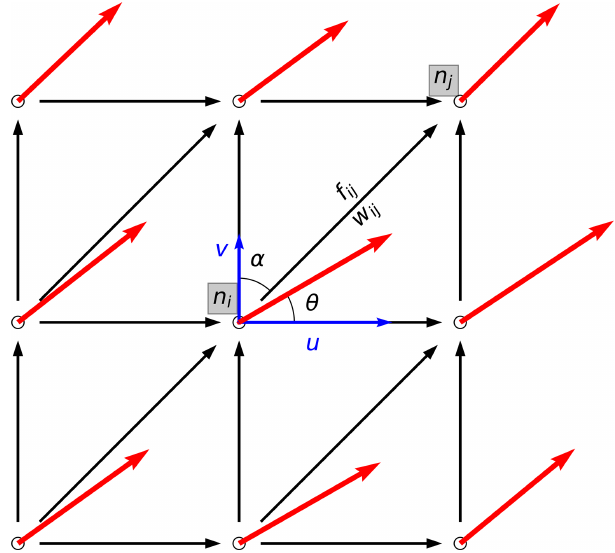
Figure A1. Schematic diagram illustrating the planar graph built from the AR pixels and horizontal moisture fluxes. Nodes are taken from pixels within region I k and are represented as circles. Red vectors denote IVT vectors. The one at node n i forms an angle θ with the x axis and has components ( u , v ). Black arrows denote di- rected edges between nodes, using an 8-connectivity neighborhood scheme. The edge between node n i and n j is e ij and forms an az- imuth angle α with the y axis. w ij is the weight attribute assigned to edge e ij , and f ij is the along-edge moisture